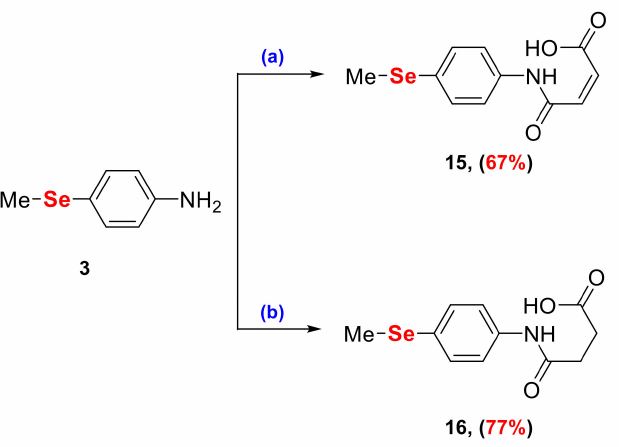
Scheme 4. Reactions of 4-(methylselanyl)aniline 4 with anhydride. Reagents and